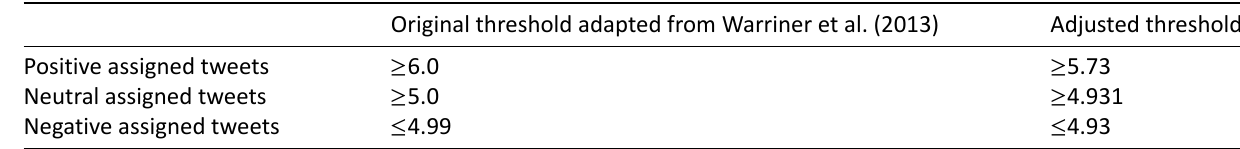
Table 2. Original and adjusted thresholds used to assign automated tweet scores into positive, neutral and negative cate-